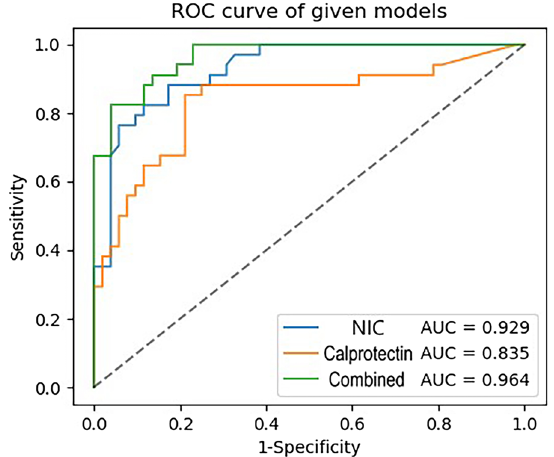
Fig. 5 The receiver operating characteristic curve of the NIC, calprotectin, and combined model for the diagnosis of mucosal